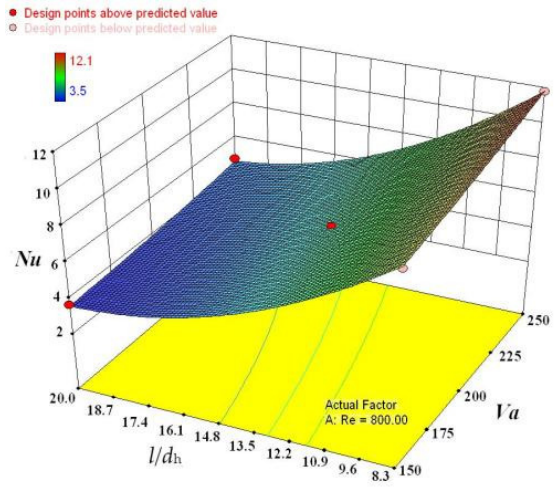
Figure 4. Response surface with a fixed maximum Reynolds number of 800.